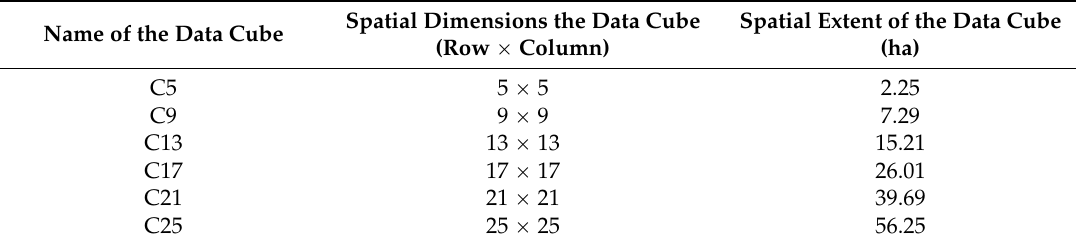
Table 1. Data cube names and their spatial extents and dimensions for the Bolivian and Brazilian sites. Name of the Data Cube